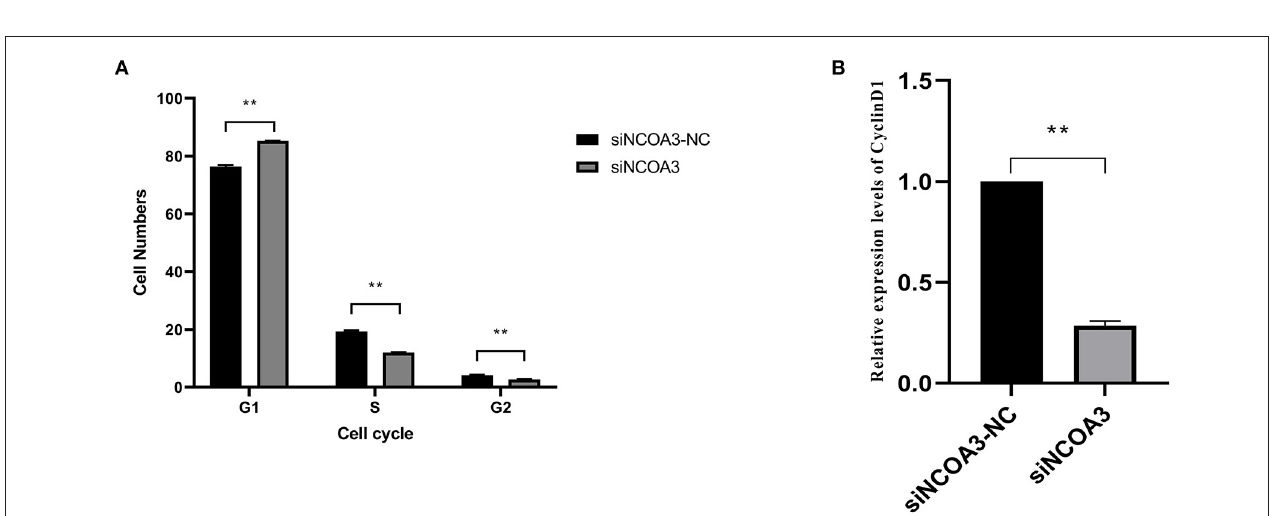
FIGURE 6 | The effect of interfering expression of NCOA3 on the proliferation of PSCs. The effect of inhibiting the expression of NCOA3 on EdU staining. The results of the percentage of EdU positive cells after interfering expression of NCOA3 .